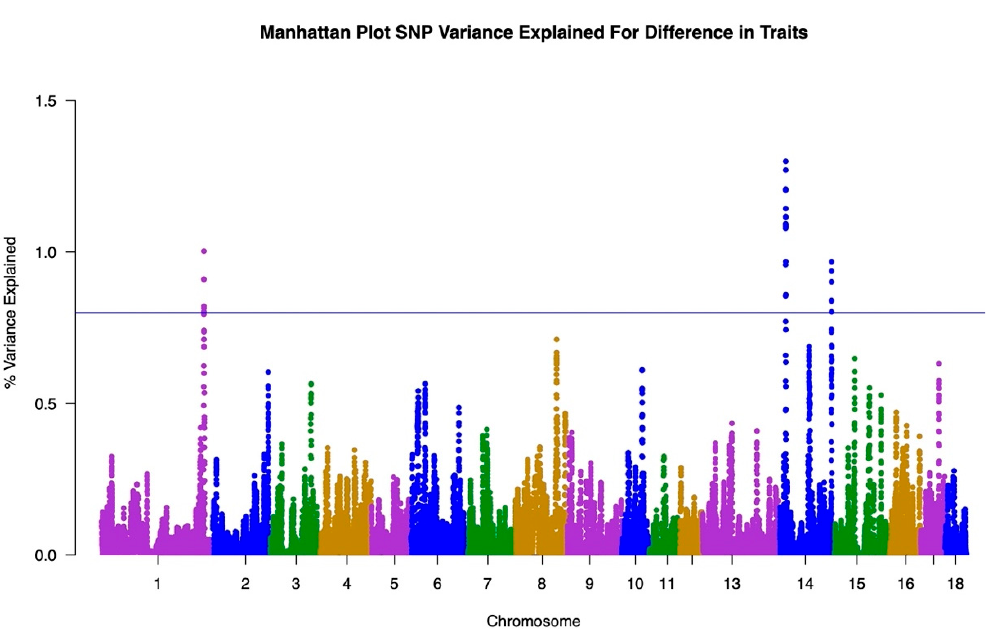
Figure 2. Manhattan Plot representing the Genome-Wide Association Study results for Trait Two, referring to HCW under thermos-neutral conditions. Chromosomes listed on x axis and percentage of variance explained listed on the y axis.